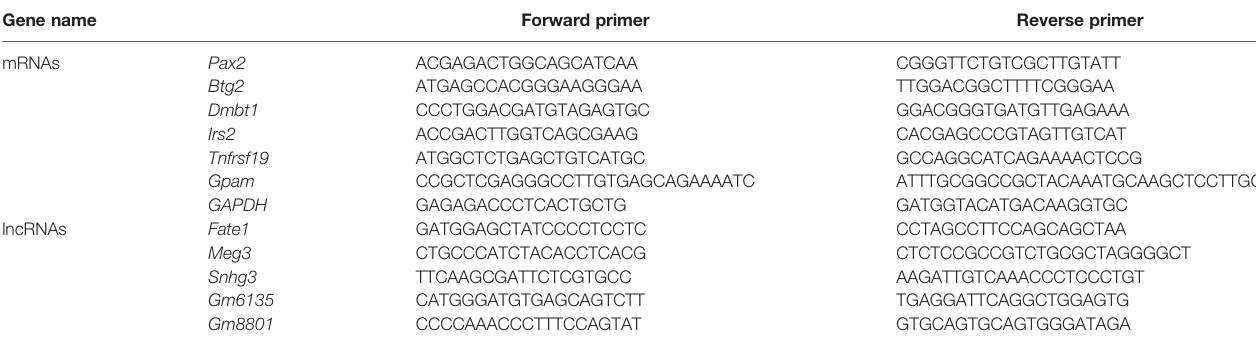
TABLE 1 | Primers used in qPCR detection of selected mRNAs and